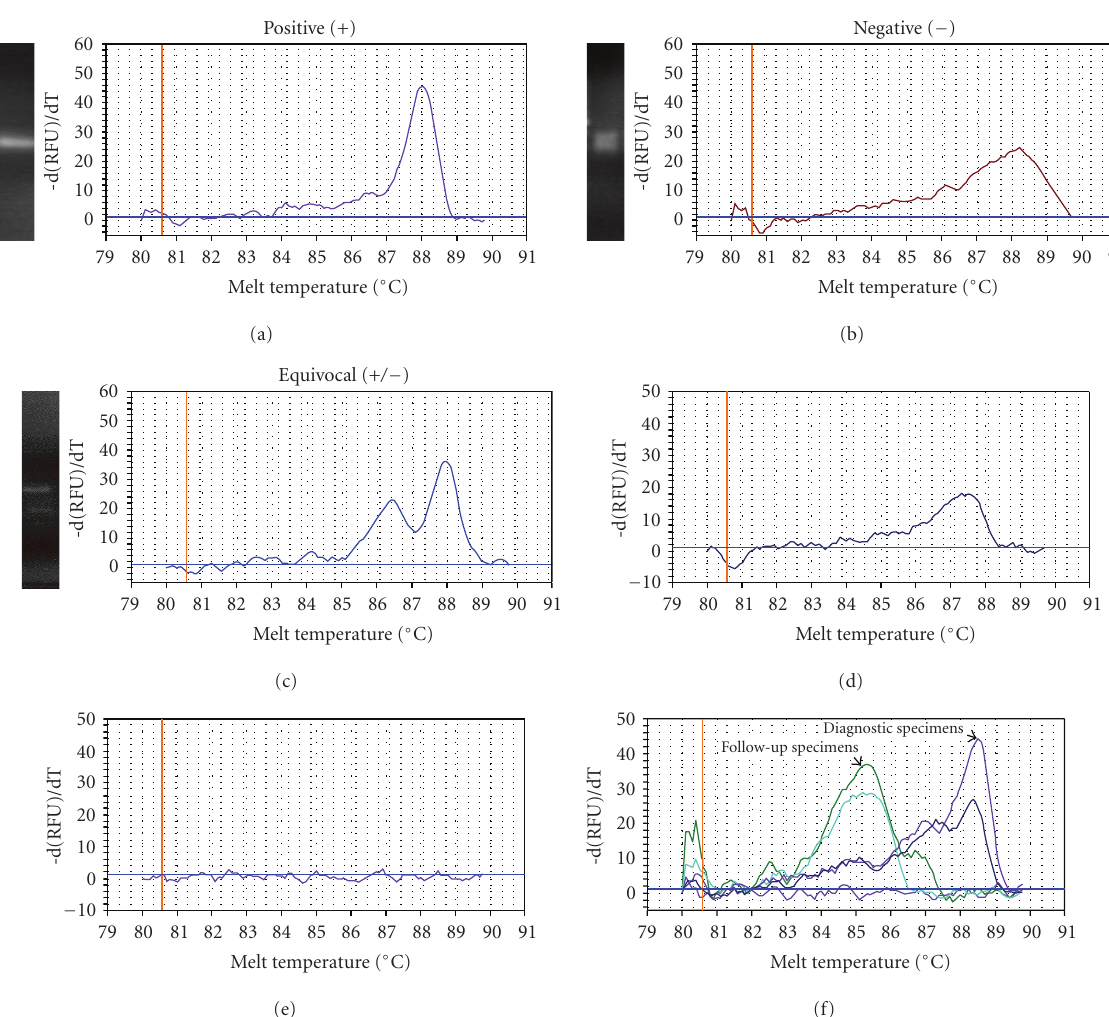
Figure 1: Examples of melt curve analyses with corresponding ethidium-stained amplified products. Melt curves displayed as − dF/dT plots: (a) defined peak with minimal to no shoulder indicates a positive MRD result; (b) a broad peak indicates a negative result; (c) a defined peak with significant shoulders indicates equivocal results. Representative 2.0% agarose gels are at the left of each of graph. Melt curves of negative controls: (d) PBMC from normal healthy individual shows a broad undefined peak; (e) water (no template) shows no peak; (f) melt curve assessment of PCR products: melt curve peak shift disparities are noted between diagnostic and followup specimens, consistent with possible di ff erent clonal di ff erentiation over time.